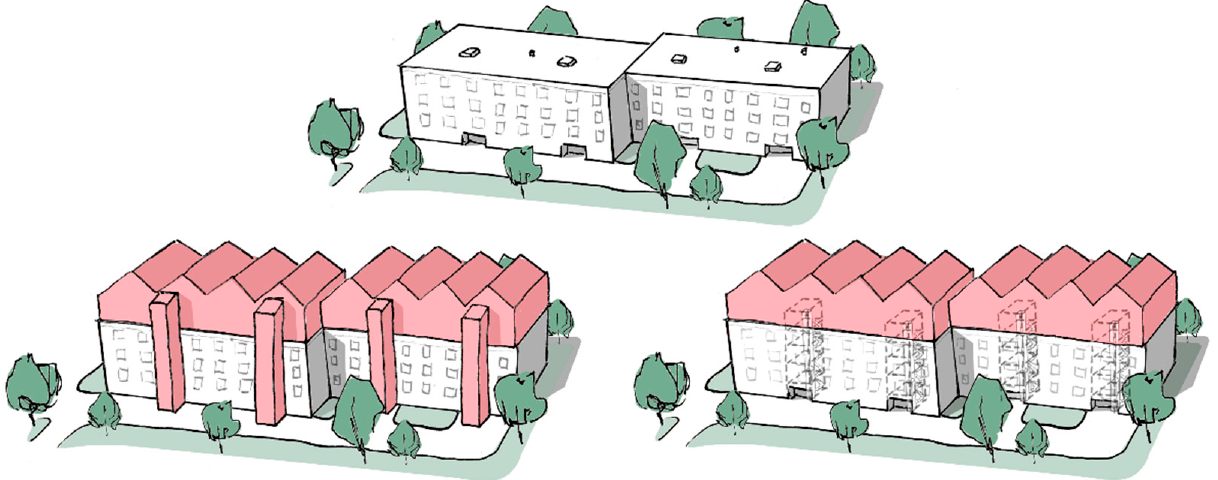
Figure 4. A retrofit elevator for additional floor construction.